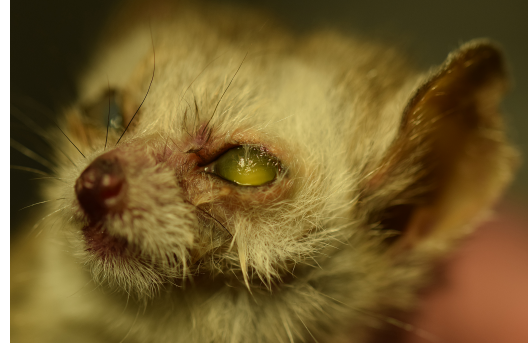
Figure 8. Post-mortem picture of a 10-year old animal affected by unilateral trichiasis of the upper eyelid on the left